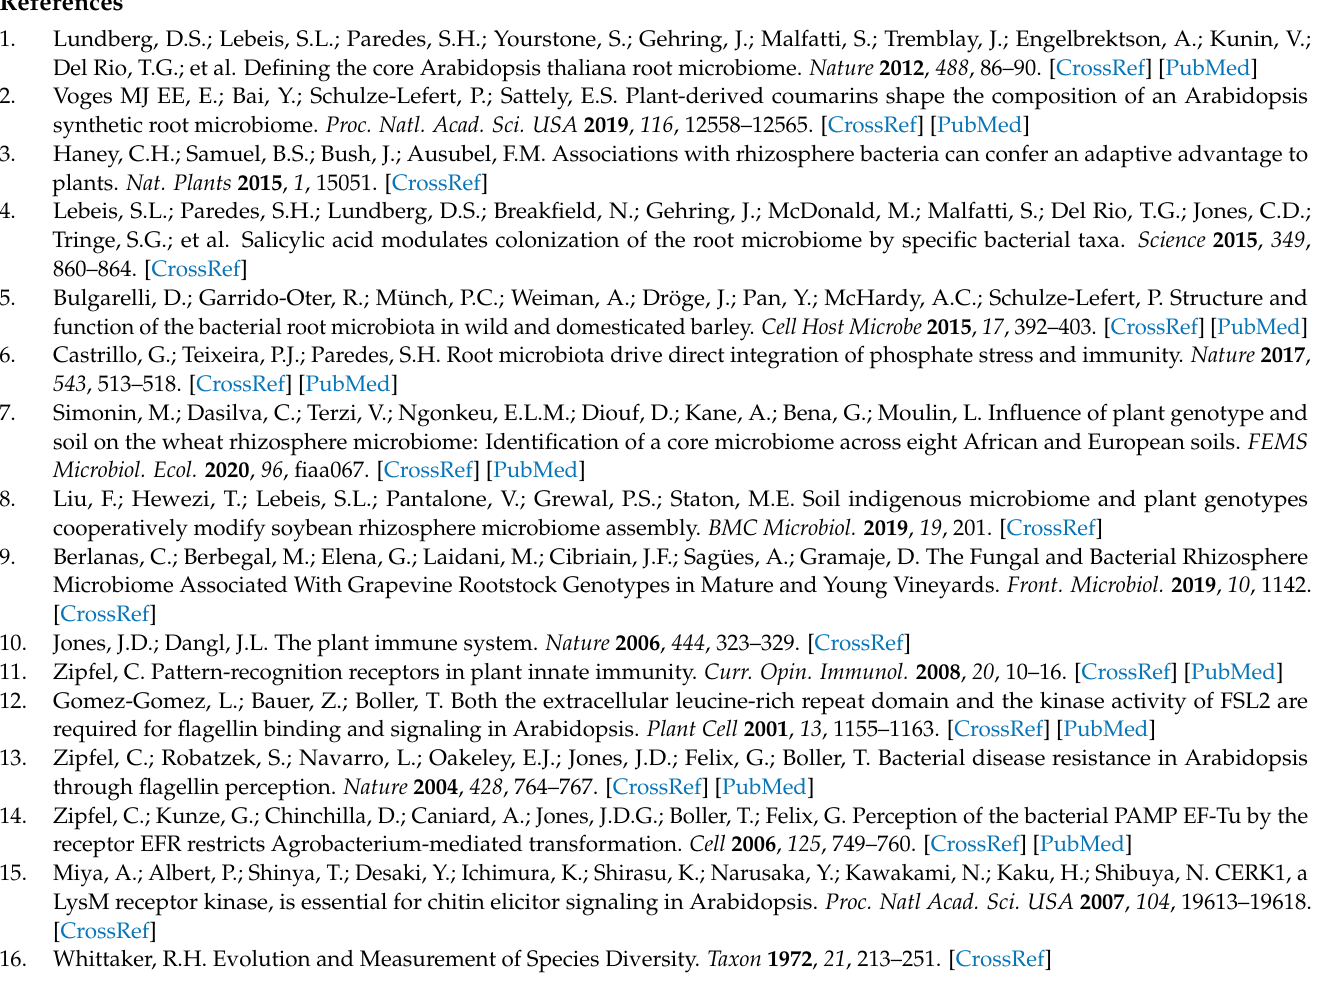
Table S5: ITS relative abundance at Phylum